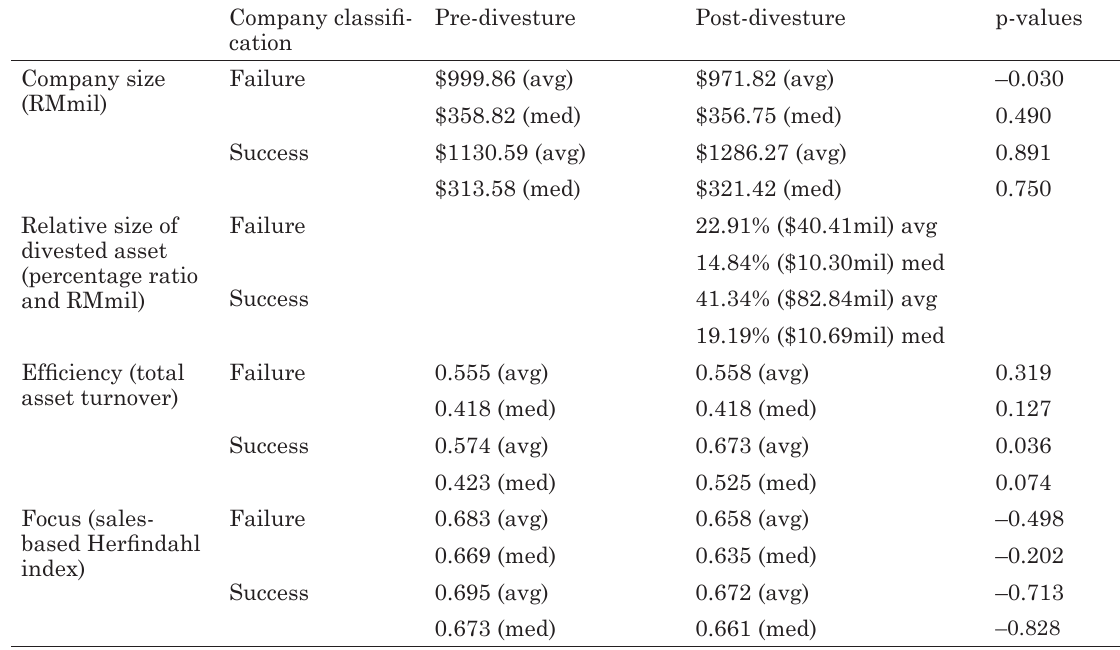
Table 2. Divesting companies descriptive statistics